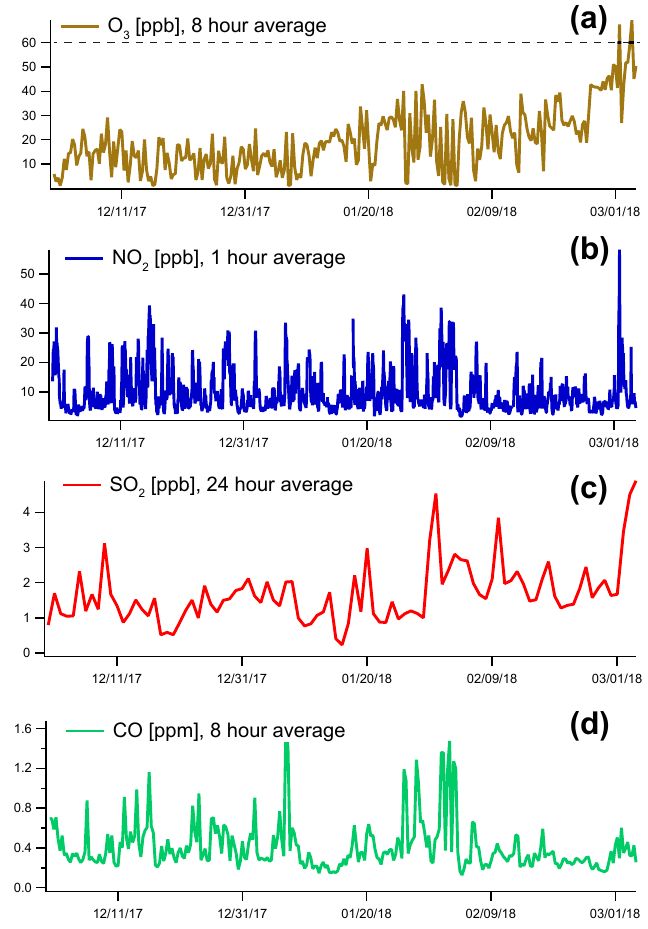
Figure 5. Time series air pollutants averaged according to the averaging period specified in the European Union legislation (indicated on each panel) for: ( a ) O 3 ; ( b ) NO 2 ; ( c ) SO 2 ; and ( d ) CO concentration. The horizontal line in ( a ) represents the limit value for O 3 according to the European Union